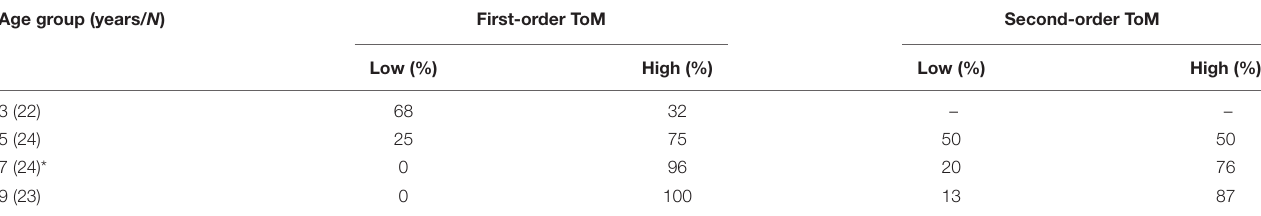
TABLE 2 | ToM descriptives.